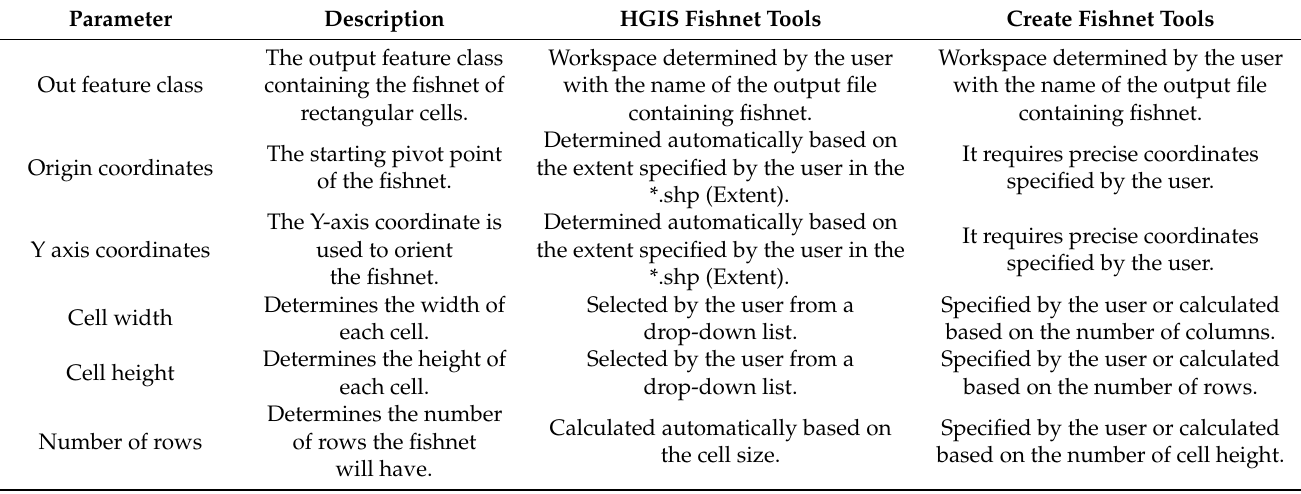
Figure 5. HGIS Fishnet Rhombus tool workflow stages: ( a ) creating lines referring to the area of study at a distance corresponding to the adopted measure unit and determining the size of the angles of the study area range, ( b ) copying and shifting horizontal and vertical lines within the range, ( c ) grid line coverage of the study area, ( d ) converting the line grid to a polygon grid and trimming of the grid to the extent of the study area. Table 3. Comparison of the parameters and functionality of the standard Create Fishnet tool (standard ArcToolbox—ArcMap 10.7) and HGIS